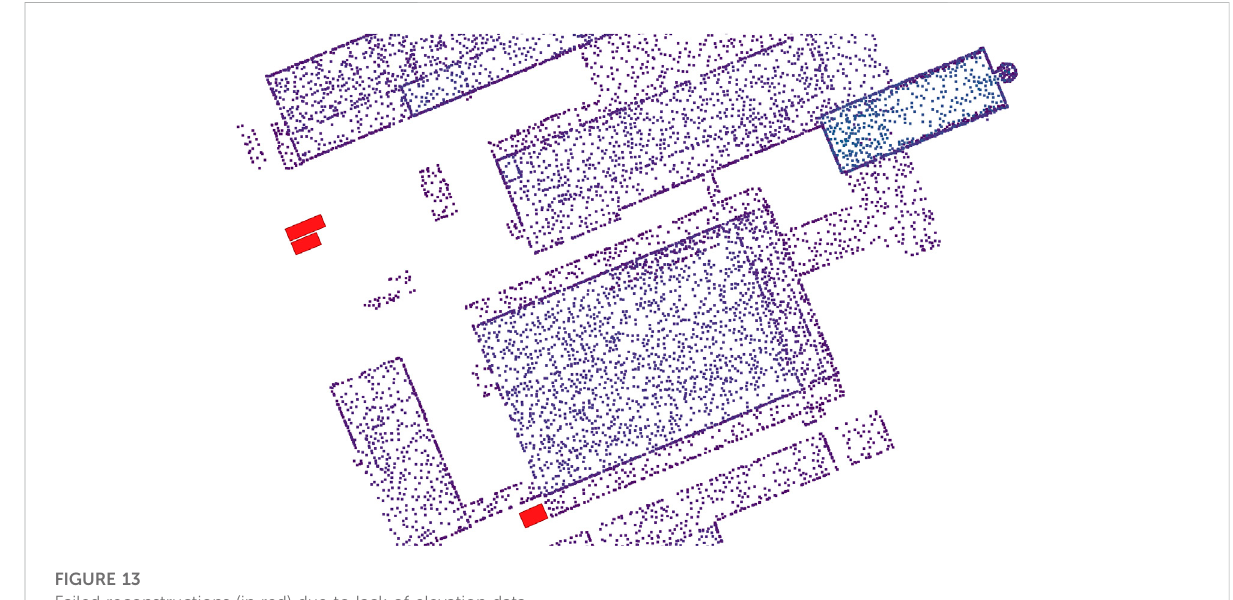
FIGURE 13 Failed reconstructions (in red) due to lack of elevation data.